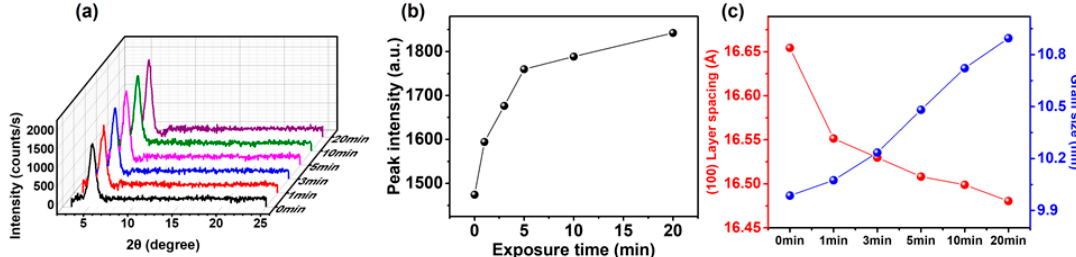
Figure 6. ( a ) Grazing incidence X-ray diffraction (GIXRD) profiles of P3HT-NW films annealed with CF vapor for various times (i.e., 0, 1, 3, 5, 10, and 20 min). ( b ) (100) peak intensity of P3HT-NW films as a function of annealing time. ( c ) Plots of the corresponding (100) layer spacing (left axis) and crystal grain size (right axis) along the (100) direction.